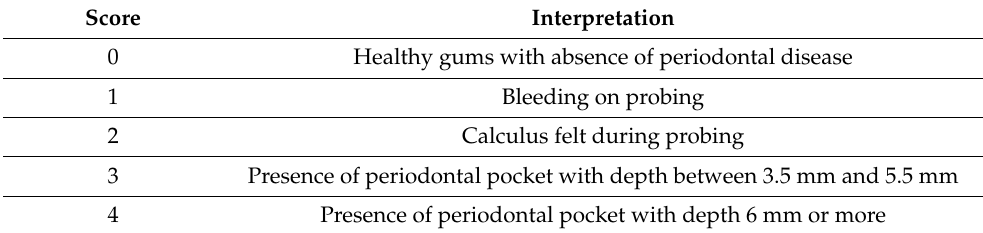
Table 2. Scoring criteria of periodontal disease based on WHO